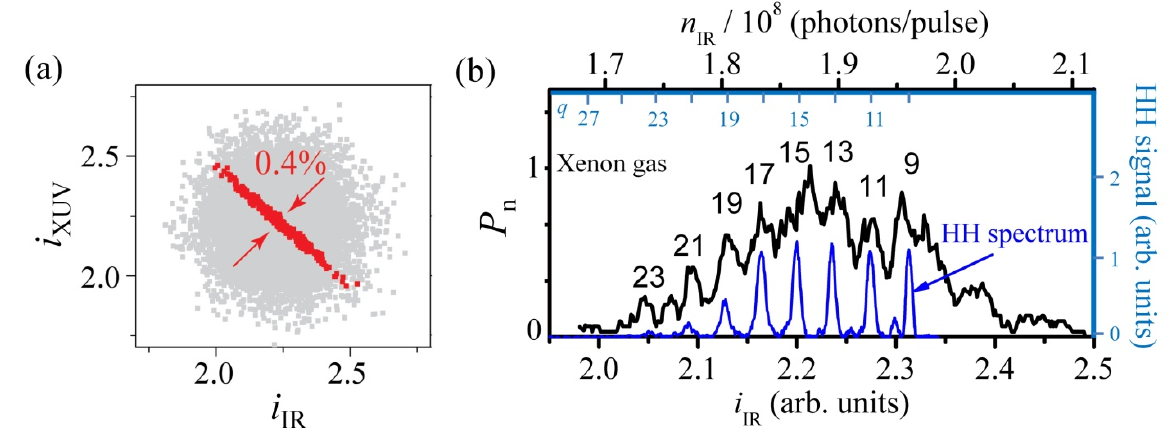
Figure 2. ( a ) Gray points: Joint IR-vs.-XUV photon number distribution. The high harmonics were generated by the interaction of an ≈ 25 fs IR laser pulse with Xenon gas. Red points: points along the anti-correlation diagonal of width w anti ≈ 0.4%. ( b ) Black line: probability of absorbing IR photons ( P n ) towards the harmonic emission. The continuum is a background of the XUV-IR uncorrelated shots introduced by the QS, due to a larger width than the optimum value of the anti-correlation diagonal, as explained in more detail in the text. Blue line: High harmonic spectrum recorded by a conventional grating XUV spectrometer. The vertical and horizontal axis of the HH spectrum are shown in blue color. The figures are reproduced from ref. [27].